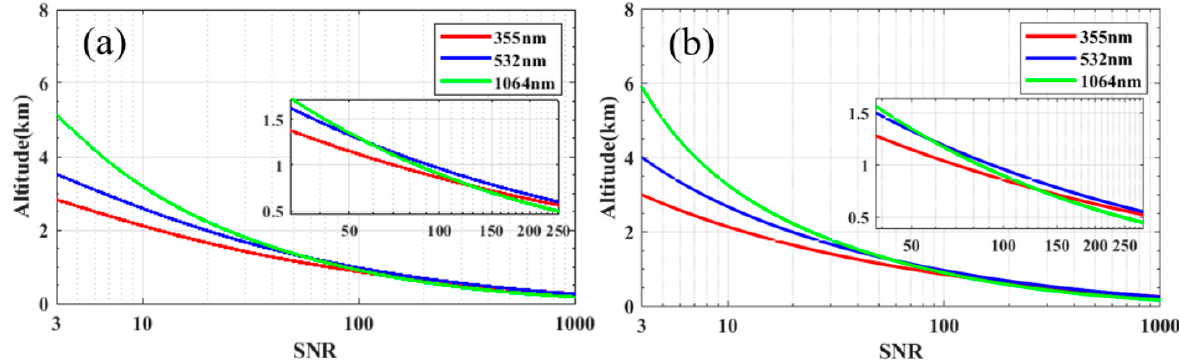
Figure 2. SNR curves for lidar wavelength of 355 nm (red), 532 nm (blue), 1064 nm (green) at day- time ( a ) and nighttime ( b ). ( a ) and nighttime ( b